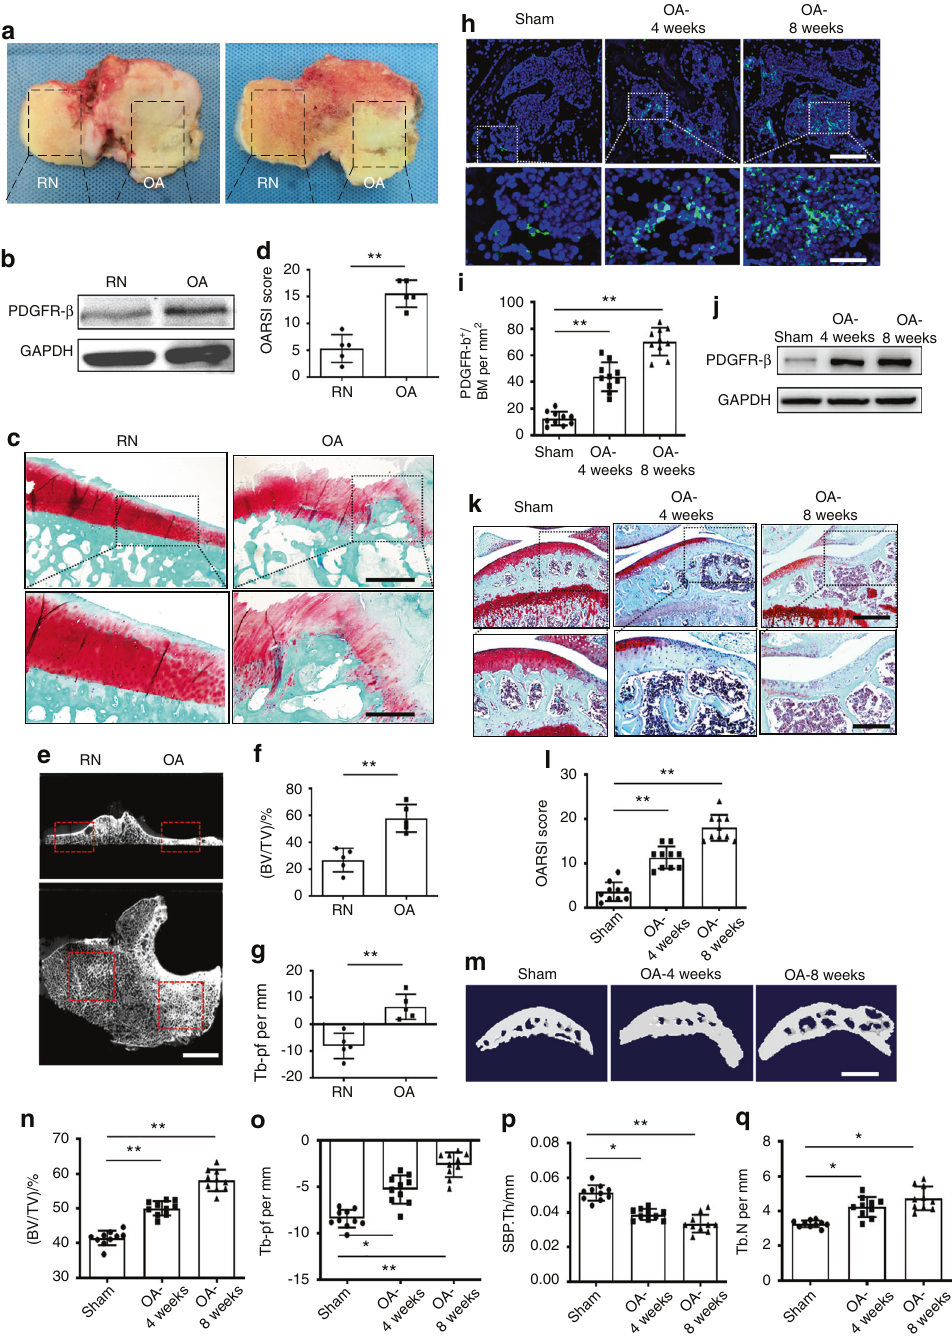
Fig. 1 Subchondral PDGFR- β is elevated during OA pathogenesis in humans and mice. a Gross inspection of tibial plateau samples acquired from patients who underwent total joint arthroplasty. RN = relatively normal part; OA = damaged osteoarthritic part. b Western blot examination of subchondral PDGFR- β expression in OA or RN tissues. c Safranin O and fast green (SOFG) staining of subchondral bone in the OA and RN parts from human osteoarthritic tibial plateau samples (upper) with the magni fi ed area (bottom) in the boxed area in the upper image; proteoglycan (red) and bone (green). Scale bar, bottom 50 µm; top 100 µm. d OARSI-modi fi ed Mankin scores of articular cartilage. n = 5. e μ CT images of subchondral bone from human osteoarthritic samples. Upper: coronal μ CT images of subchondral bone; bottom: cross-section of μ CT images of subchondral bone; RN part (left box area) and OA part (right box area). Scale bar, 500 μ m. Quantitative analysis of BV/TV ( f ) and Tb.pf ( g ). h Immunostaining of subchondral PDGFR- β -positive cells (upper) in mice with a magni fi ed area (bottom) in the boxed area in the upper image in the sham and 4-week and 8-week post-ACLT groups. Scale bar, bottom 50 µm; top 100 µm. i Quanti fi cation of subchondral PDGFR- β -positive cells in the mice in the sham and 4-week and 8-week post-ACLT groups. n = 10. j Western blot examination of subchondral PDGFR- β expression in the mice in the sham and 4-week and 8-week post-ACLT groups. k SOFG staining (upper) with the magni fi ed area (bottom) in the boxed area in the upper image; proteoglycan (red) and bone (green). Scale bar, bottom 50 µm; top 100 µm. l OARSI-modi fi ed Mankin scores of articular cartilage from the mice in the sham and 4-week and 8-week post-ACLT groups. n = 10. μ CT images of medial subchondral bone from the sham and 4-week and 8-week post-ACLT groups ( m ) and quantitative analysis of BV/TV ( n ), Tb.pf ( o ), SBP.Th ( p ), and Tb.N ( q ). Scale bar, top 500 µm. n = 10. Sham = sham controls. * P < 0.05 and ** P < 0.01 compared to the sham group or as denoted by